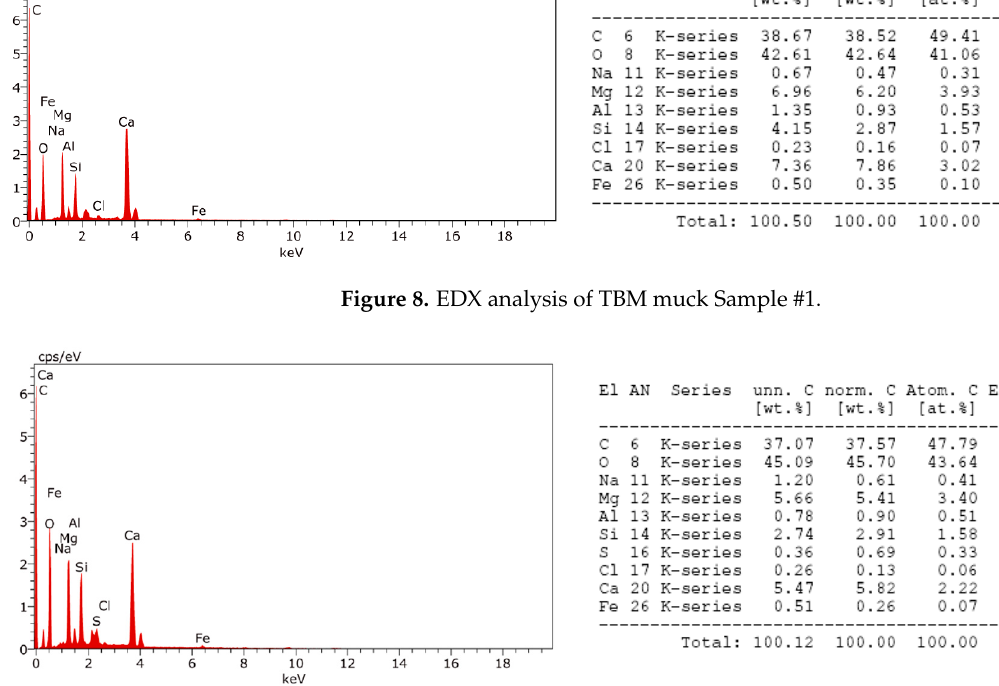
Figure 9. EDX analysis of TBM muck Sample #2.